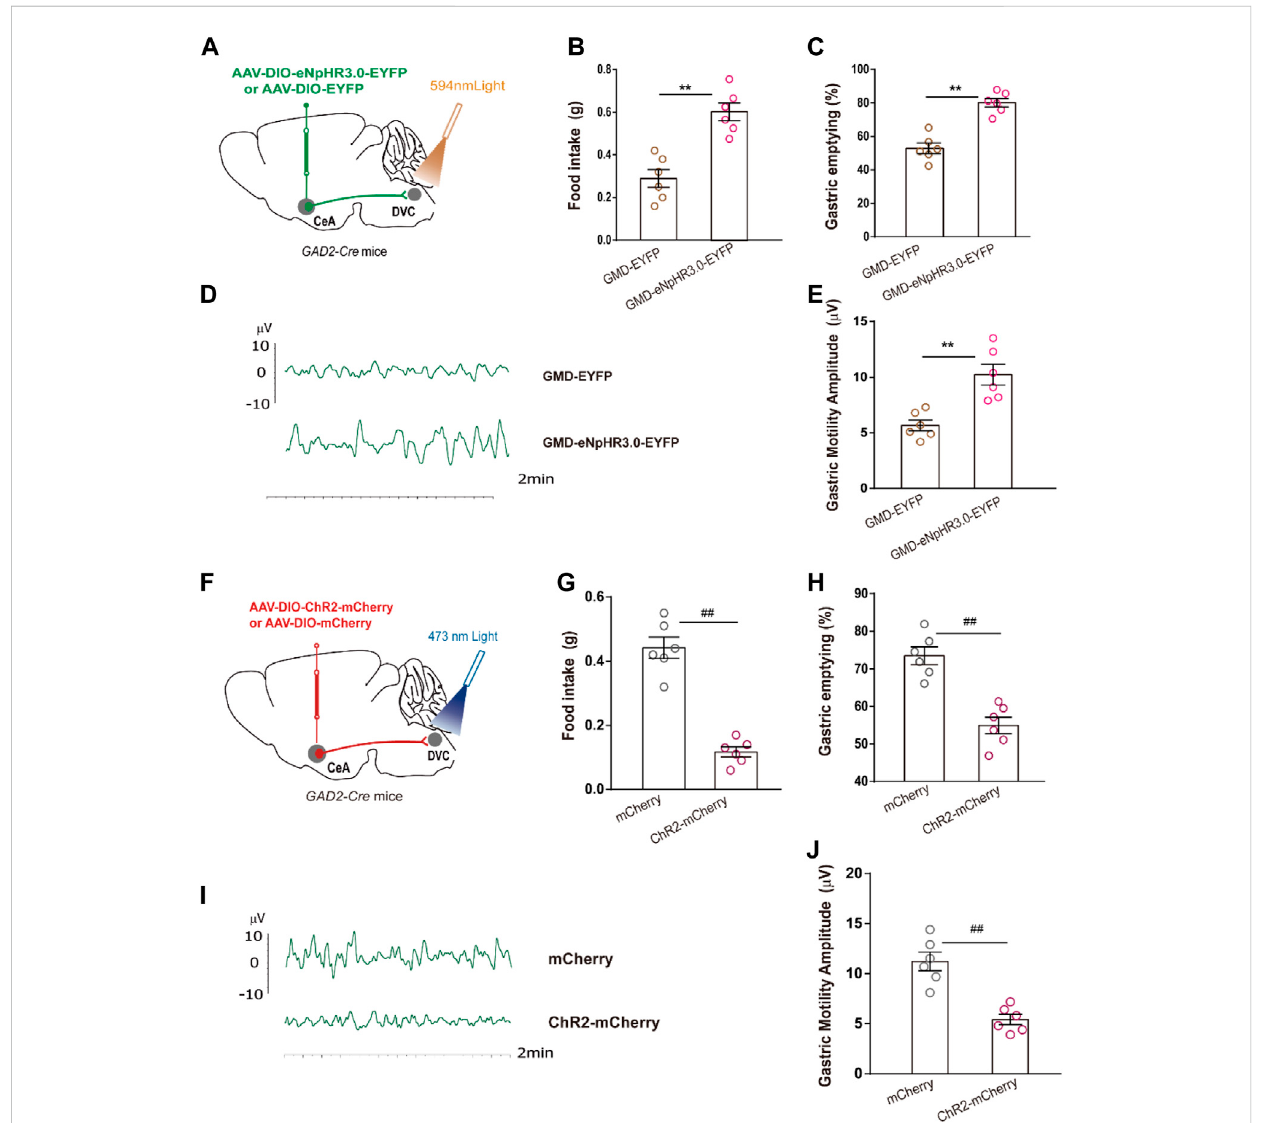
FIGURE 5 The CeA GABA → DVC pathway controls gastric motility (A) Schematic of viral injection in the CeA and optical fi bre implantation in the DVC. (B – E) Gastric motility effects of optical silencing of CeA GABA terminals in the DVC in GAD2-Cre GMD mice. [ n = 6 mice per group, food intake (B) , gastric emptying (C) and gastric motility (D, E) ] Schematic of viral injection in the CeA and optical fi bre implantation in the DVC. (G – J) Gastric motility effects of opticalactivationofCeA GABA terminalsintheDVCof GAD2-Cre mice[ n =6micepergroup,foodintake (G) ,gastricemptying (H) ,gastriccontraction (I, J) ]. All of the data are presented as the mean ± SEM. ## p < 0.01, ** p < 0.01. Unpaired t -test for (B, C, E, G, H, J)